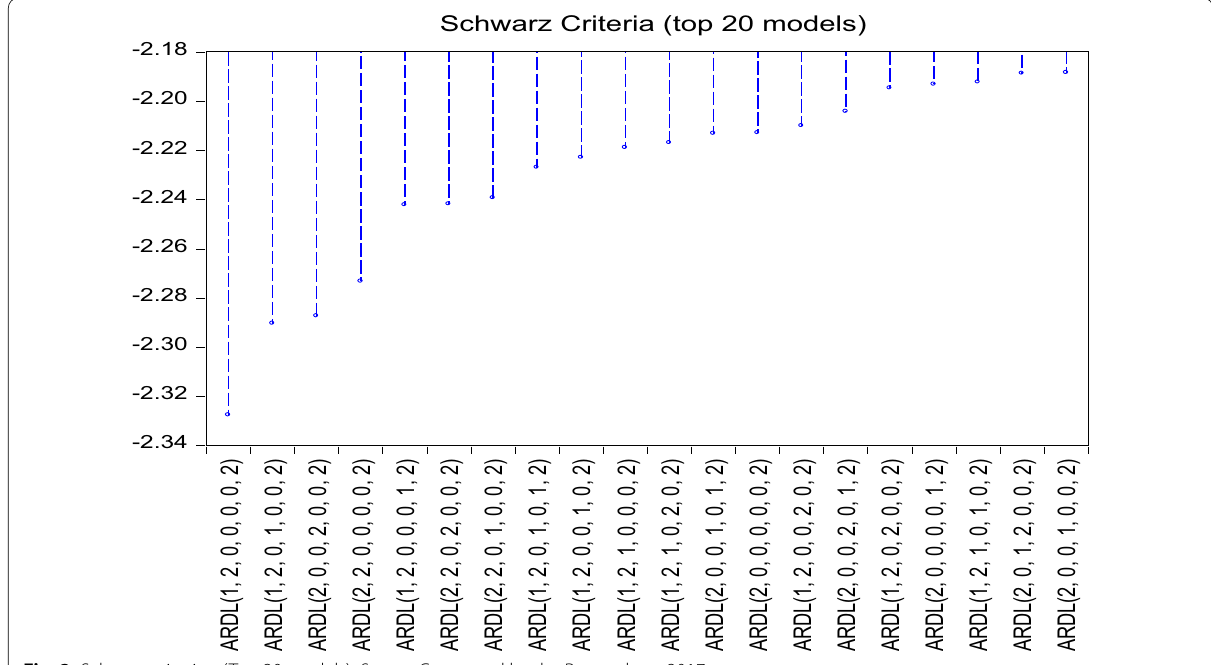
Fig. 2 Schwarz criterion (Top 20 models). Source : Computed by the Researchers, 2017